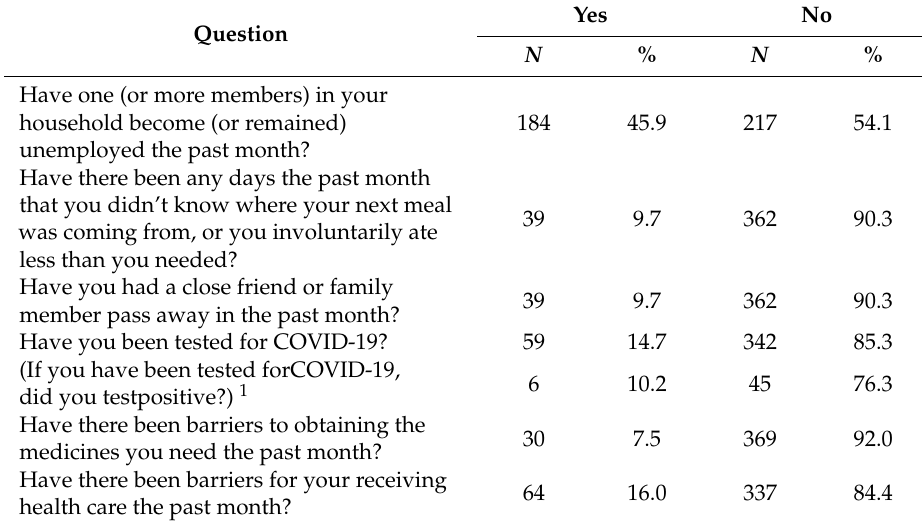
Table 2. Participants’ self-reported experience on the Pandemic Adverse Events